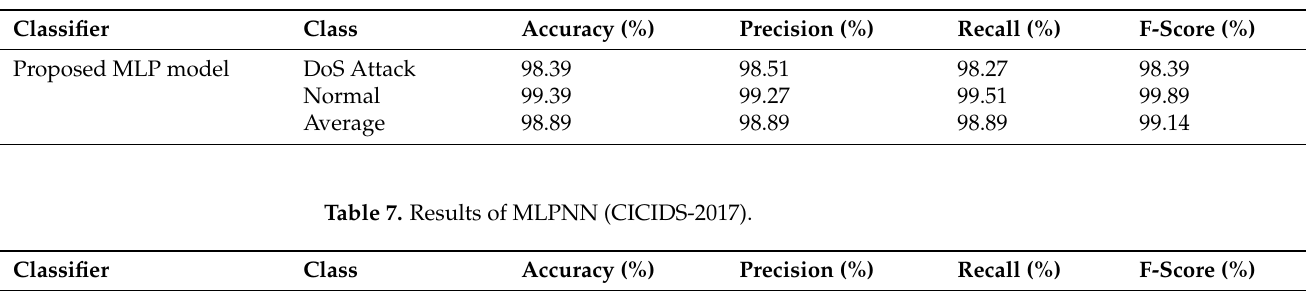
Table 6. Results of MLPNN (NSL-KDD).